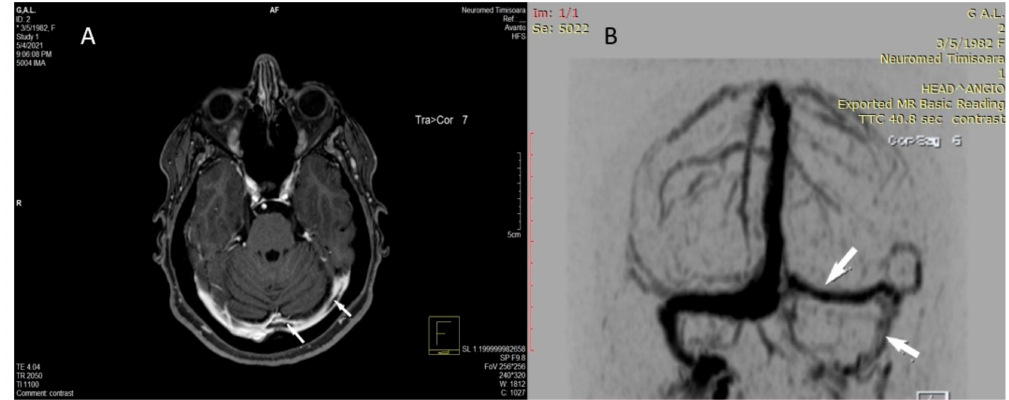
Figure 5. ( A , B ) Axial and sagittal T1 MPR postcontrast magnetic resonance images after 6 months, demonstrating persistent partial filling defects throughout the dural sinuses (left transvers sinuses and sinus confluence ( A ), straight sinus ( B